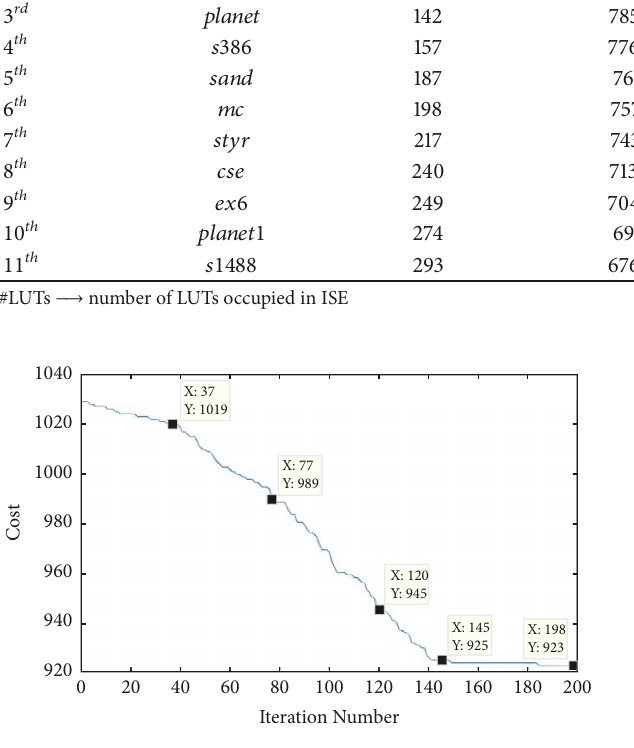
Figure 5: Convergence plot for the state assignment using logarith- mic barrier function based gradient descent approach after adding the last constituting FSM in the proposed architecture.